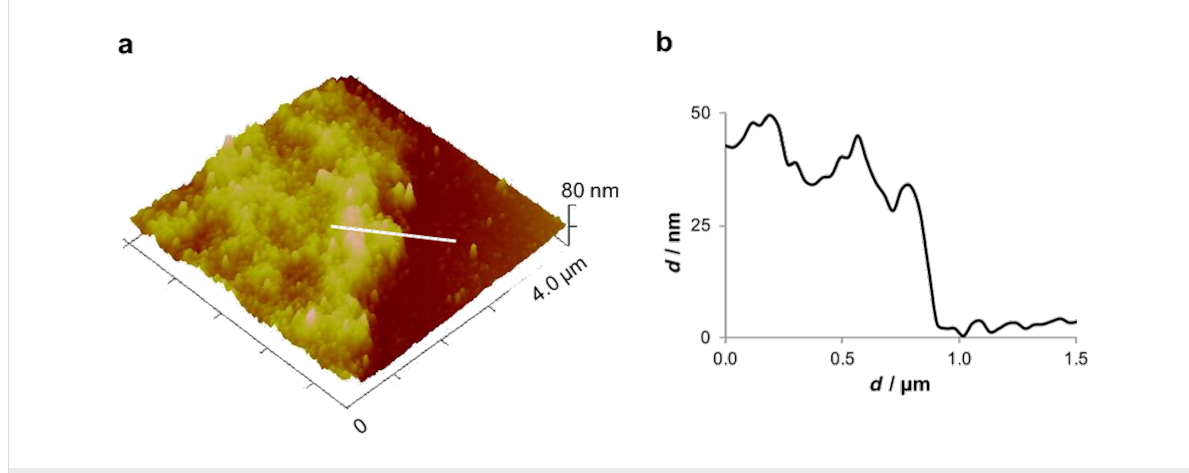
Figure 2: Peak force tapping AFM (PFT-AFM) image (a) and height profile (b) of Paracentrotus lividus moist footprints at the edge of the adhesive material. Image obtained with a ScanAsyst-Air probe.